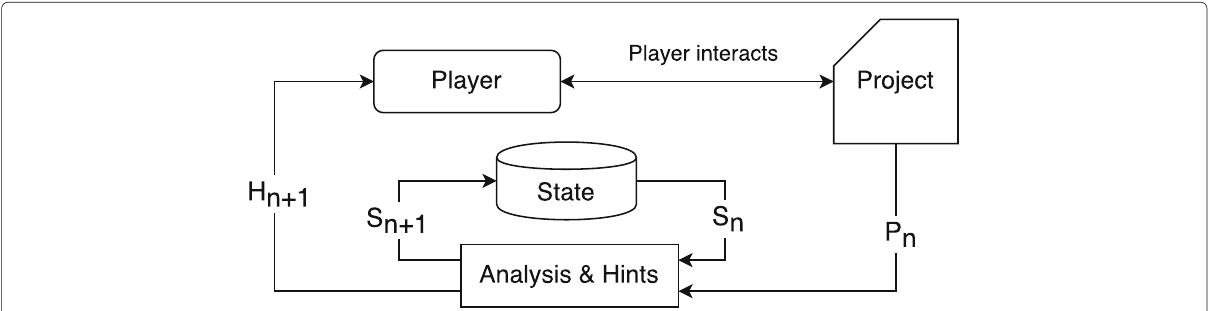
Fig. 5 Conceptual game overview: interaction and